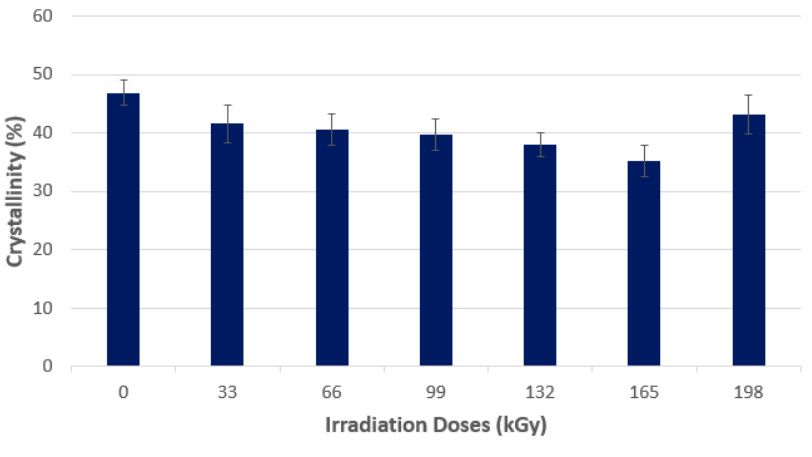
Figure 8. X-ray diffraction—Crystallinity—Commodity polymers (HDPE).